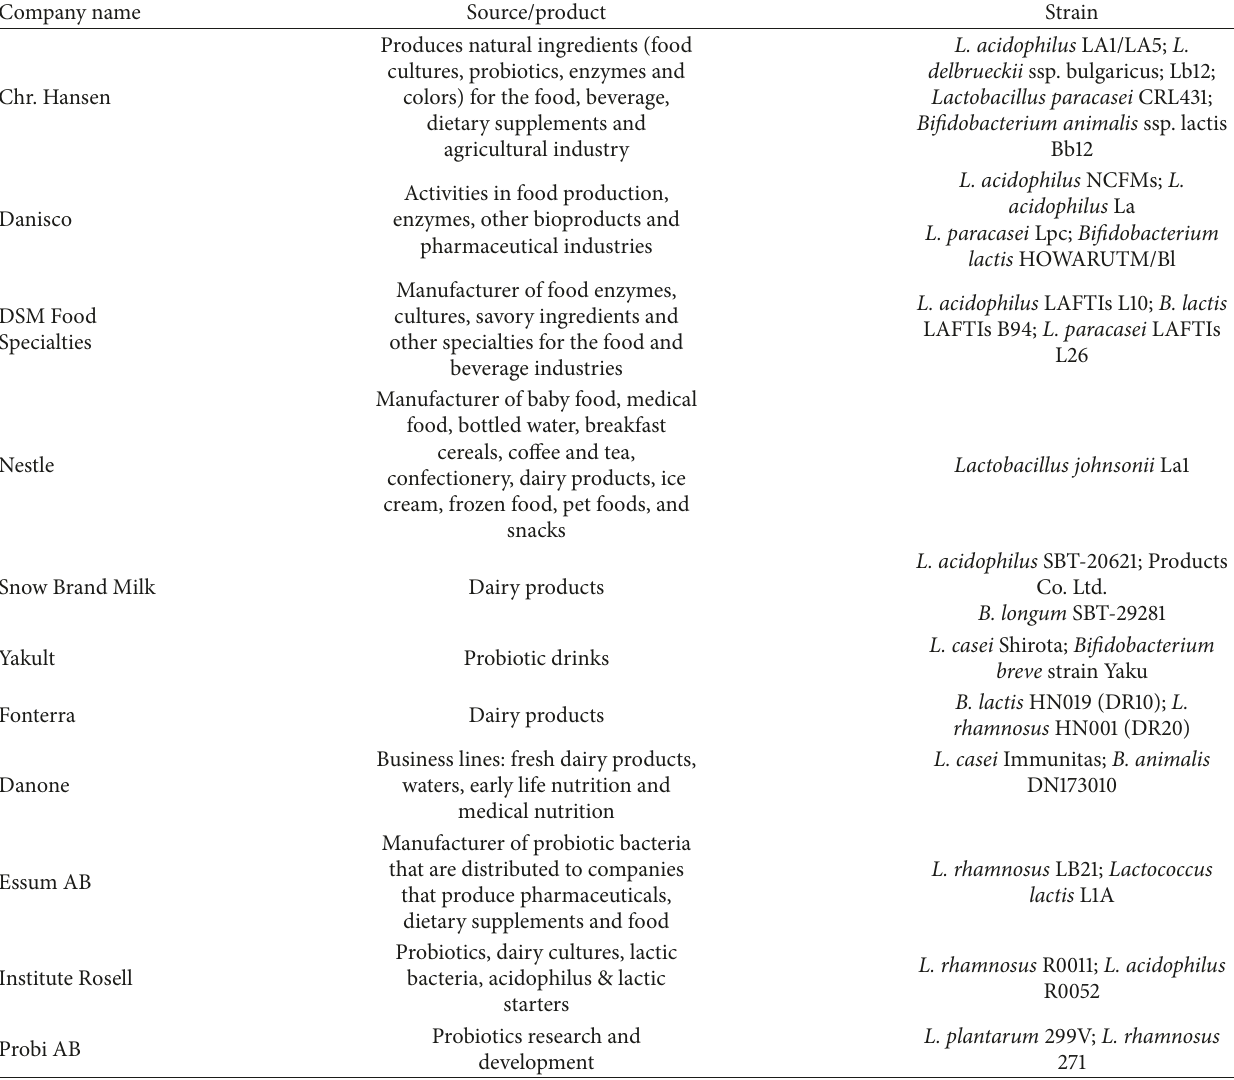
Table 3: List of probiotic strains used in commercial applications